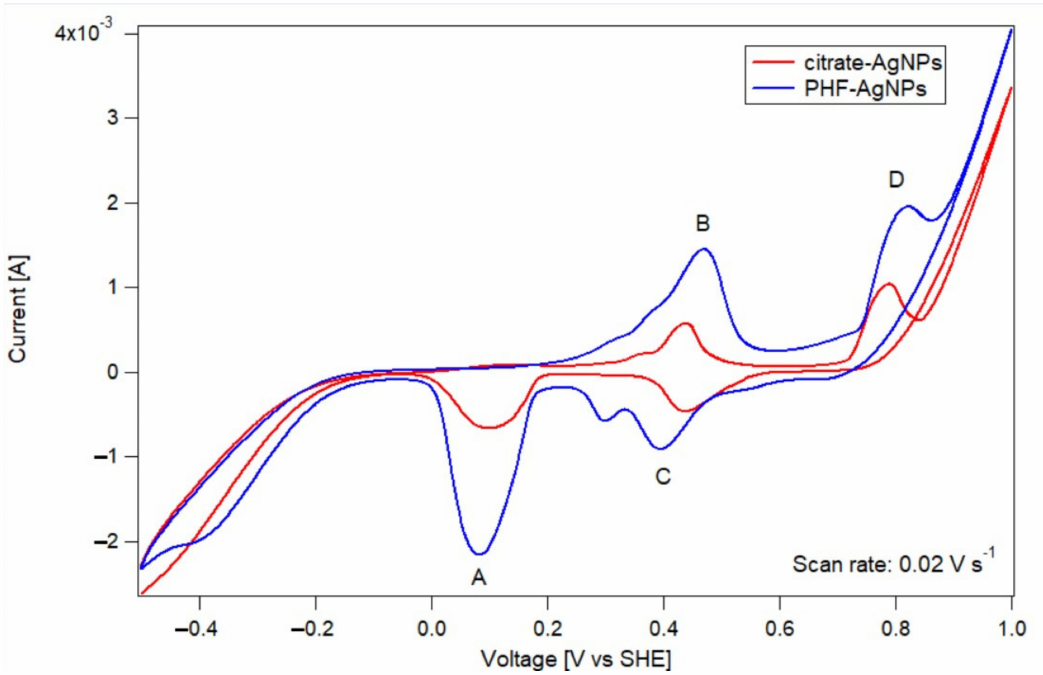
Figure 4. Cyclic voltammograms for the citrate-AgNP-CNT electrode (red) and the PHF-AgNP- CNT elec-trode (blue). In both cases, the scan rate was 0.02 V s − 1 and the electrolyte used was 0.1 M KOH. Labeled peaks correspond to reduction of oxidized Ag (A), silver oxidation (B), oxygen reduction reaction (C) and oxygen evolution reaction (D), and show clearly an increased activity for the PHF-AgNPs with respect to the conventional citrate-AgNPs. Voltages are given with respect to the hydrogen standard electrode. There was no degassing using N2 nor another compound. Comparable amounts of silver are considered in both